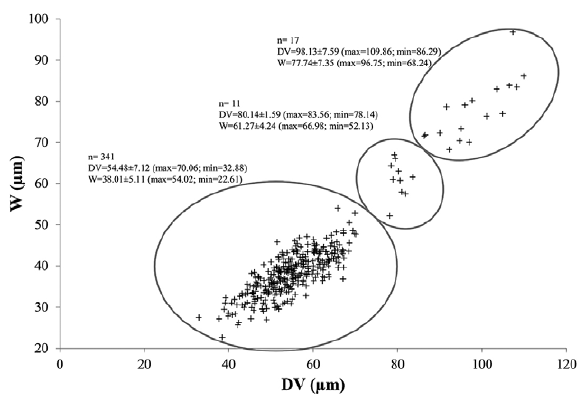
Fig. 2. – Dorsoventral (DV) and width (W) diameters of Ostreopsis cells from field samples, n=369.